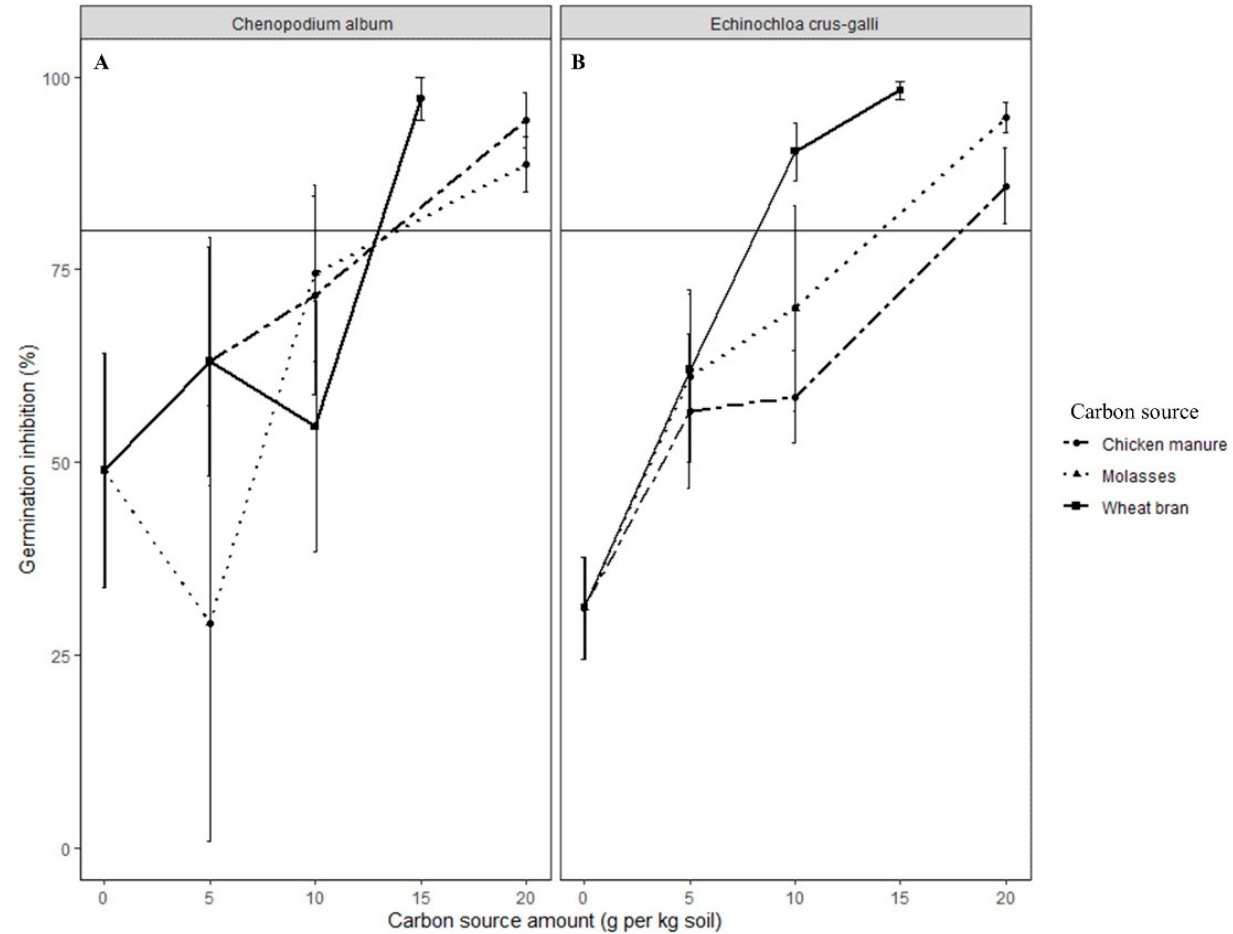
Figure 4. Effect of different rates of anaerobic soil disinfestation (ASD) carbon sources on inhibition of germination of resident seeds of ( A ). common lambsquarters ( Chenopodium album ), ( B ). barnyardgrass ( Echinochloa crus-galli ) under growth chamber conditions. Data presented are from two independent experiments, each with three replications. Error bars indicate standard error.